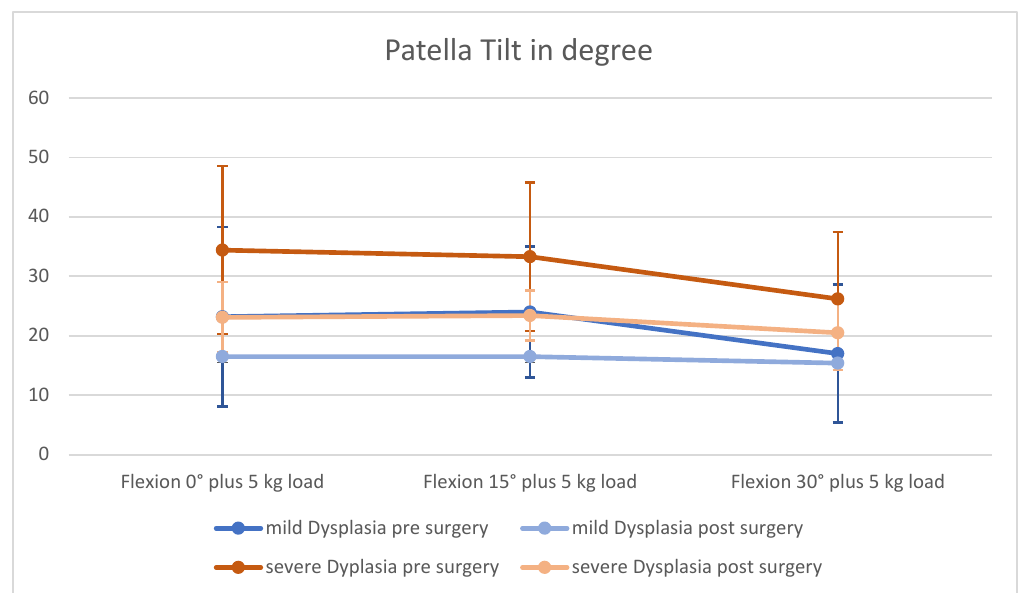
Figure 3. Patella tilt without loading before and after surgery.